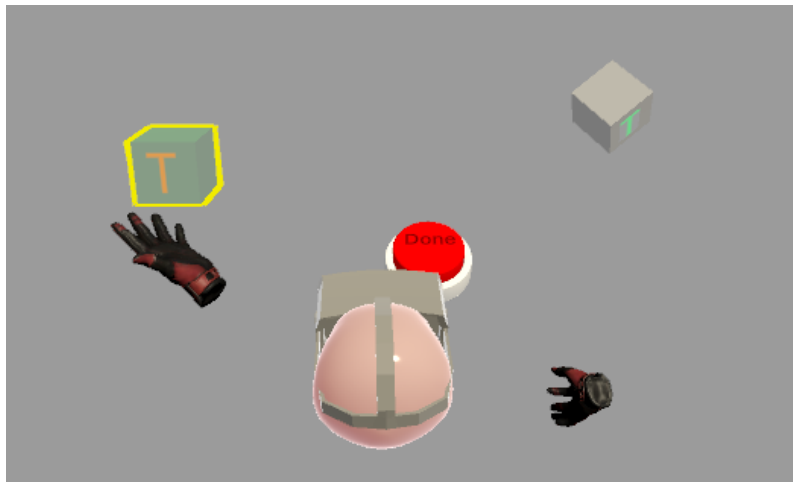
Figure 2. The participant sat with the headset on and manipulated the virtual cubes either by holding the controllers or with bare hands. In this example, the participant is about to pick an object with her right hand in the Controller+Grab condition.